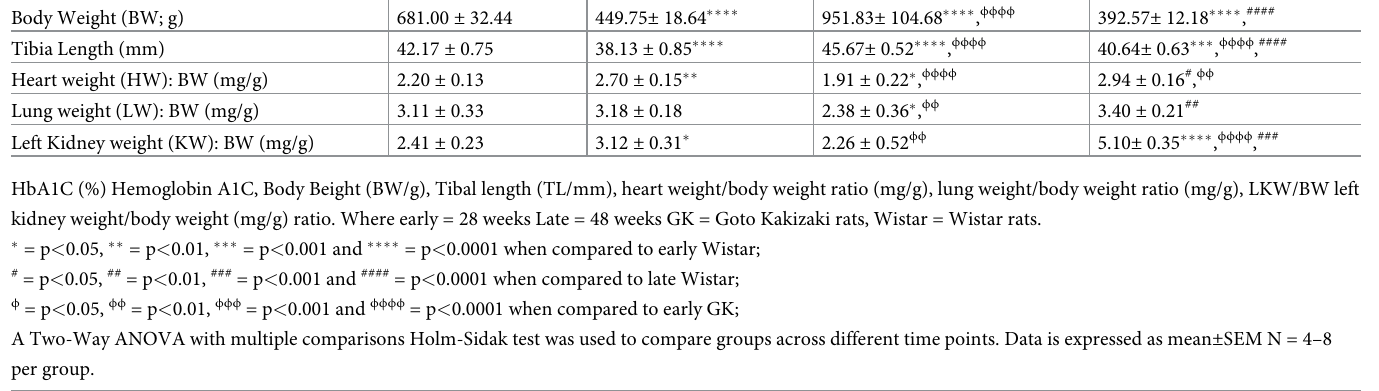
(p = 0.0012). Lung weight indexed to body weight (LW:BW, Table 1) was significantly increased in GK rats compared to Wistar rats at the late time point (p < 0.01) and significantly increased over time in GK rats (p = 0.0308). Kidney Weight indexed to body weight (KW:BW, Table 1) significantly increased in GK rats at both early (p < 0.05) and late (p < 0.001) time points compared to Wistar rats and there was a time dependent increase in both Wistar and GK rats (p < 0.0001).